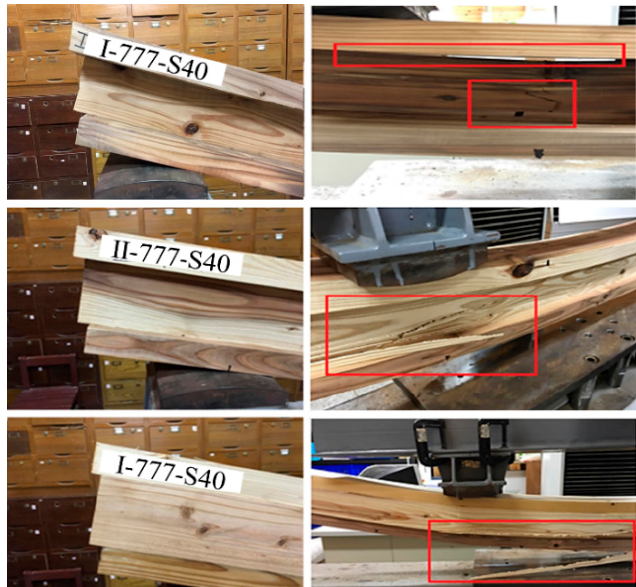
Figure 6. Failure usually resulting from the bottom flange at the position directly below the loading loading position.